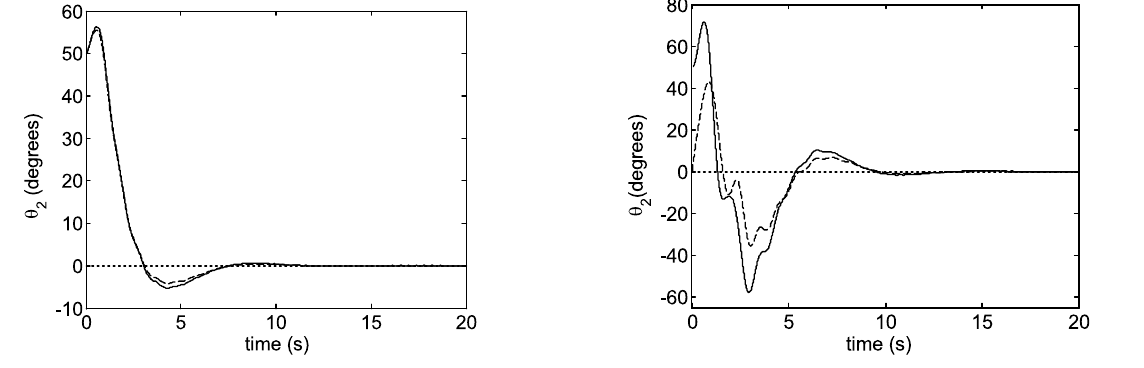
Fig. 6. Estimated (- - -) and “real” (—) behavior of measured vari- able θ 2 considering same initial conditions.